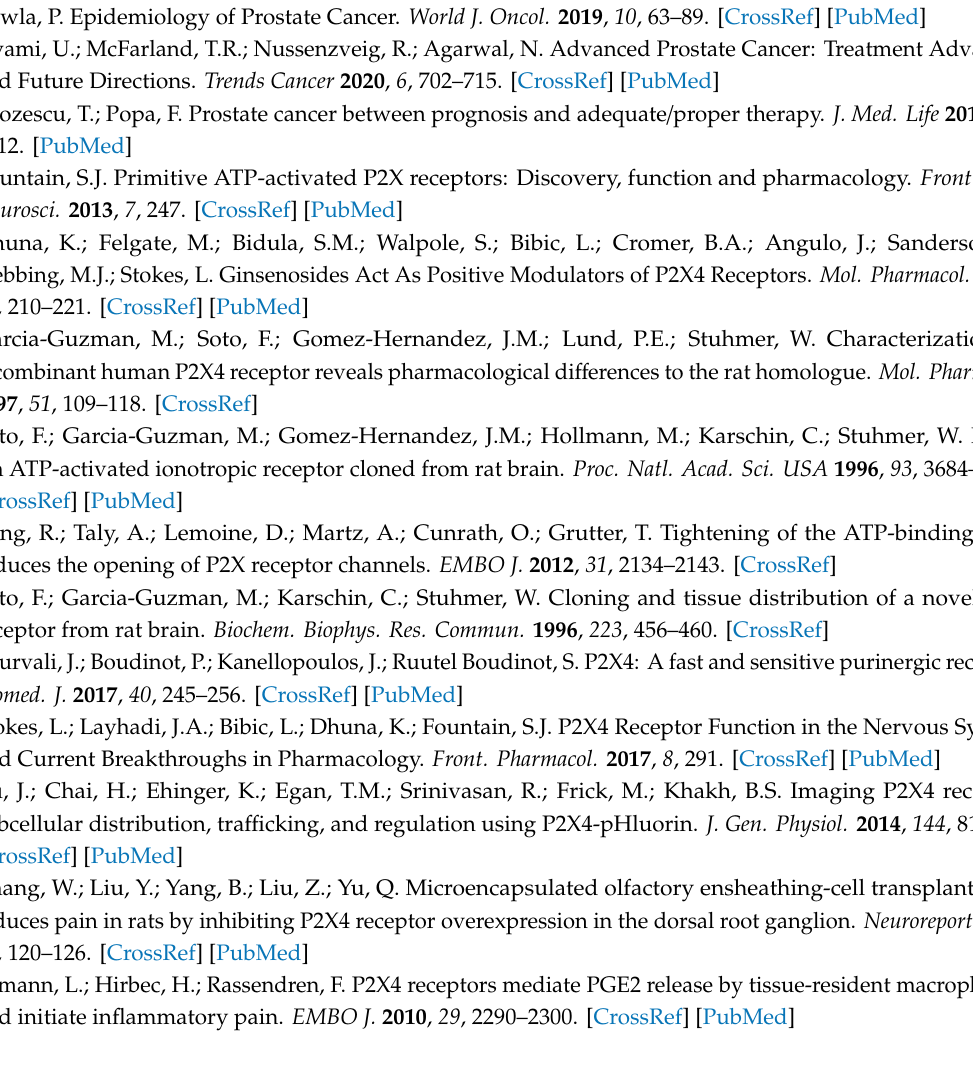
Figure S1: ATP induced calcium influx can not be detected in C4-2B4 cells., Table S1: List of TaqMan qRT-PCR gene expression